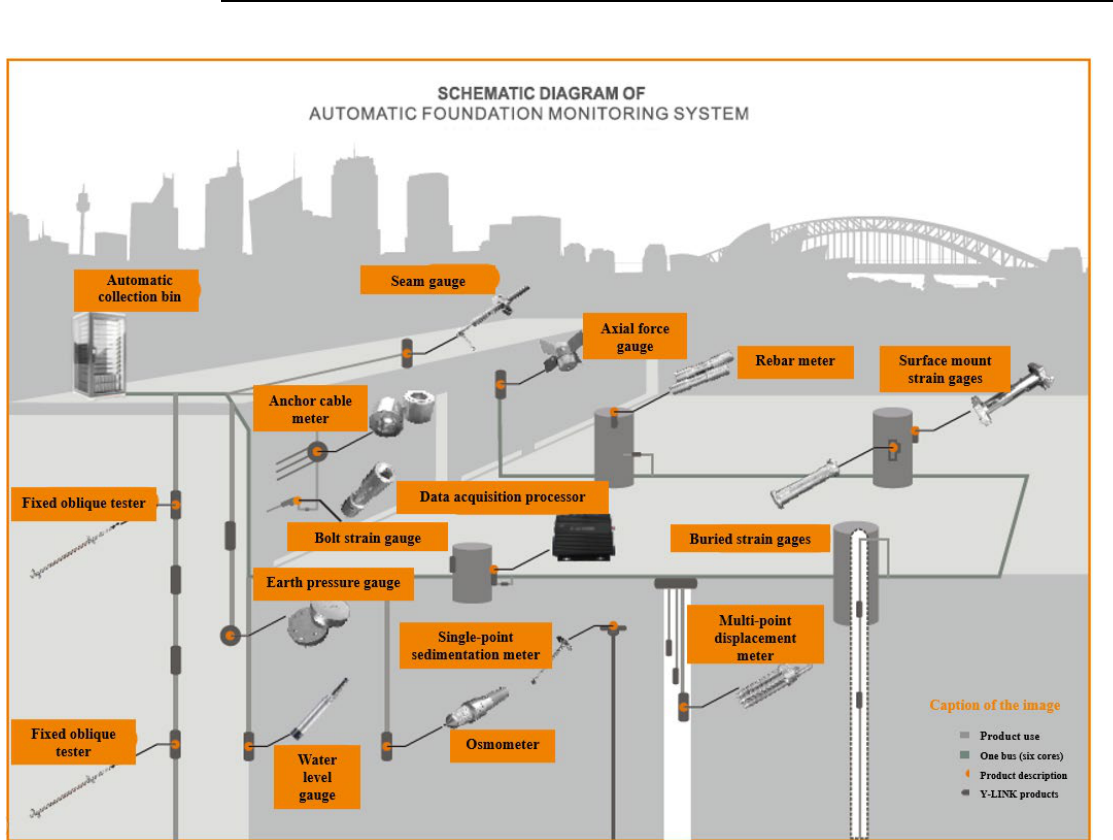
Figure 9. Layout plan of monitoring points of foundation pit.